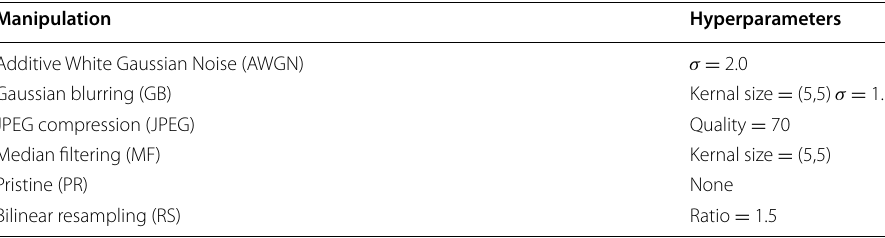
We used the same parameters as in [9] for fair comparison. See Sect. 3.7 for details on the manipulations